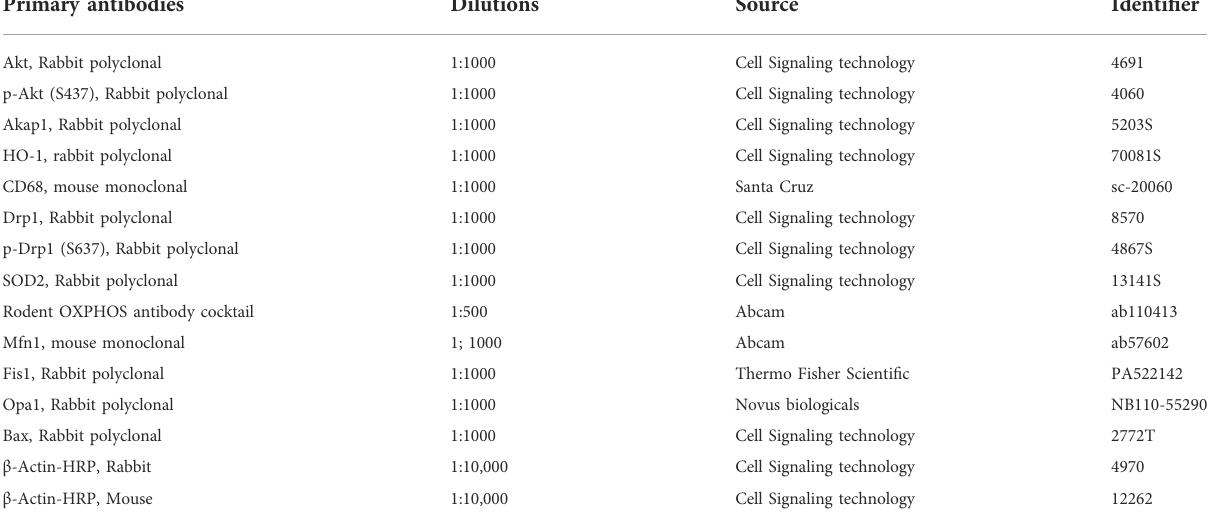
TABLE 1 List of Primary Antibodies used in this study. Primary